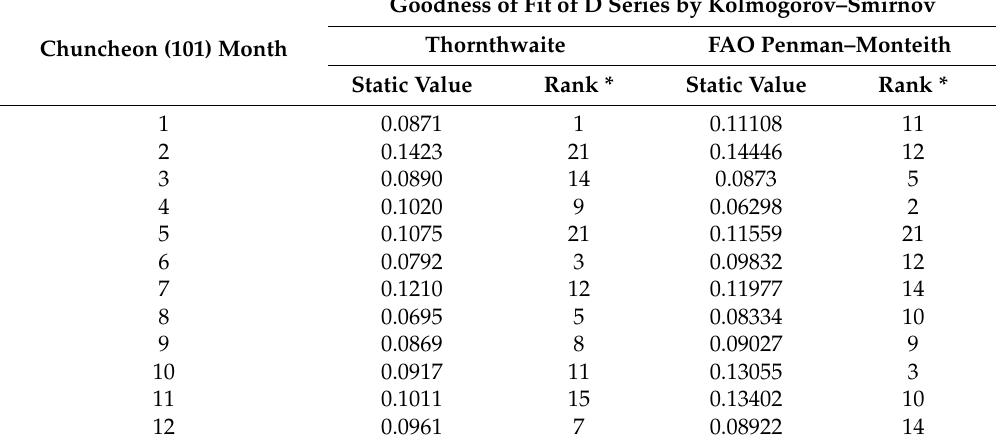
Table 3. Goodness of fit of log-logistic distribution of D series from 1981 to 2010 in Chuncheon